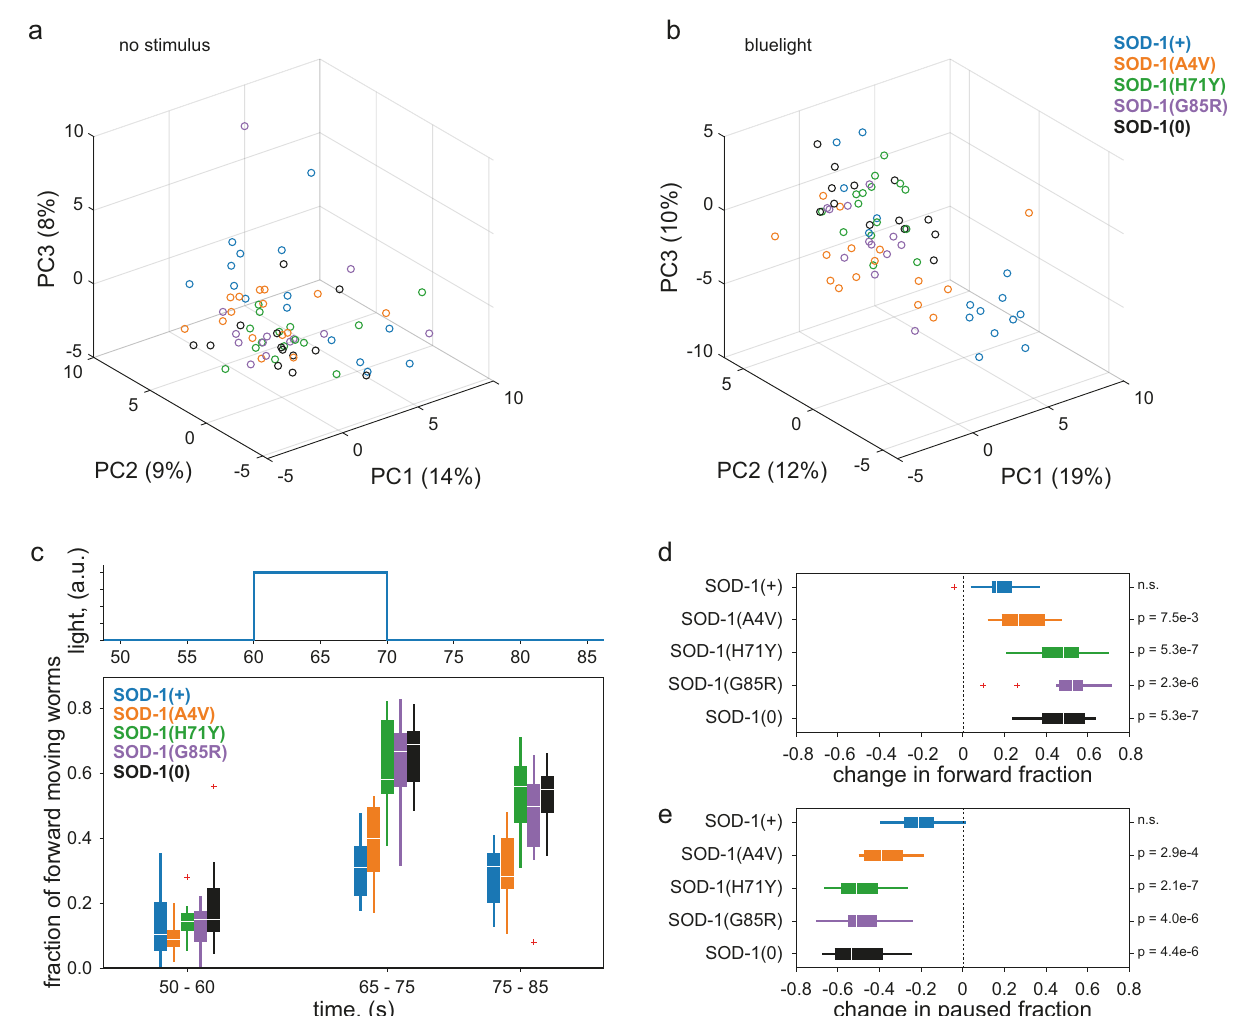
Fig. 4 Blue light stimulation elicits different responses amongst ALS disease models. a – b Principal component analysis of 256 extracted behavioural features from standard ( a ) or blue light ( b ) imaging conditions. Features were extracted by Tierpsy Tracker. Each datapoint represents one plate average of the strain, with up to 12 independent wells for each strain in every 96-well plate. Each well contained an average of three worms. The time window represented in B is also shown in ( c ). c Overall fraction of forward locomotion under blue-light imaging conditions. A 10 s blue light pulse started at t = 60 s and feature values were calculated using 10 s windows centred around 5 sec before, 10 s after, and 20 s after the beginning of each blue light pulse. Plate averages were used to generate the plot for each strain. Each box shows median, 25th and 75th percentile (central mark, lower and upper edge, respectively), while whiskers show the rest of the distribution except for outliers (outside 1.5 times the IQR above the 75th and below the 25th percentile), plotted individually. d – e Changes in the overall fraction of forward ( d ) or paused ( e ) locomotion upon blue light stimulation. The difference was calculated by subtracting the average feature values over the t = 50-60 sec pre-stimulus window from those over the t = 65-75sec blue light pulse window (these correspond to the fi rst and the second time points in ( c ). Plate averages were used to generate the plot for each strain. Two sample t-test compared to the SOD-1( + ) control strain (n.s. not signi fi cant). Each box shows median, 25th and 75th percentile (central mark, left and right edge, respectively), while whiskers show the rest of the distribution except for outliers (outside 1.5 times the IQR above the 75th and below the 25th percentile), plotted individually. Sample size (in wells, three worms per well): N sod-1( + ) = 232, N sod-1(A4V) = 228, N sod-1(H71Y) = 211, N sod-1(G85R) = 165, N sod-1(0) = Drug experiments . Drug experiments followed the standard phenotyping assay work fl ow, but with a few modi fi cations. A detailed protocol can be found at https:// doi.org/10.17504/protocols.io.bs6znhf6. Brie fl y, imaging plates were prepared with drugs the day before imaging and stored in the dark overnight at 4 °C. Using a COPAS 500 Flow Pilot, three worms were dispensed into each well of 96-well plates. Following liquid handling, plates were kept in a 20 °C incubator for an extra 3 hours to allow drug exposure (total drug exposure time was thus four hours).